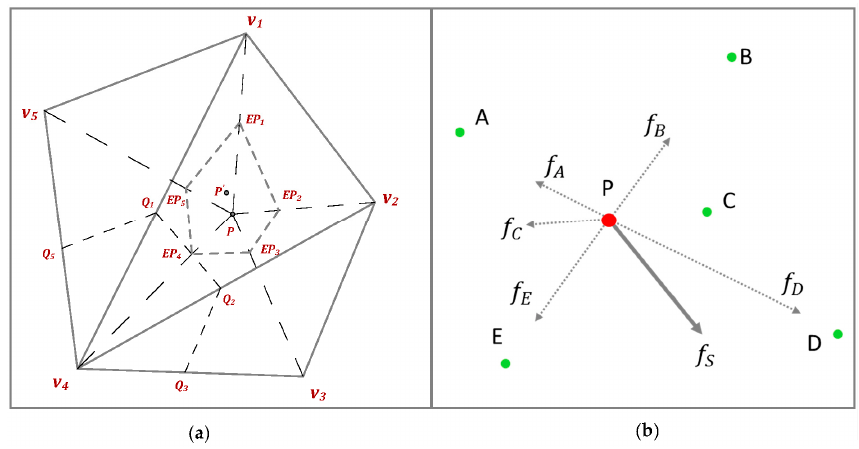
Figure 6. ( a ) The error contours for the iterative data to attribute layout error reduction; ( b ) the force